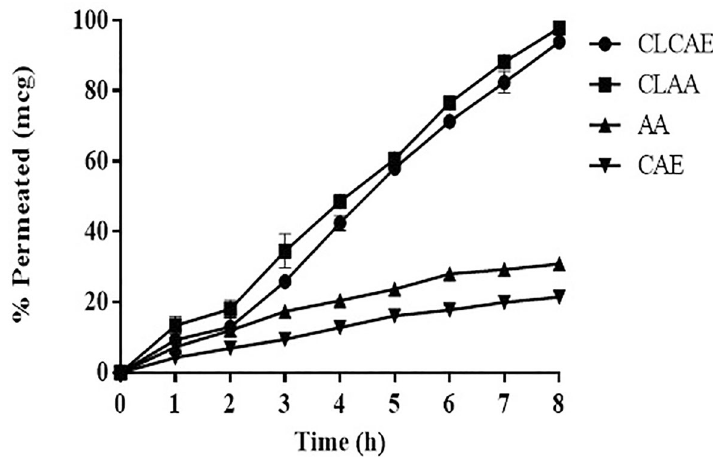
Figure 8. Ex vivo permeation study of AA, CAE, CLCAE and CLAA (n=3).